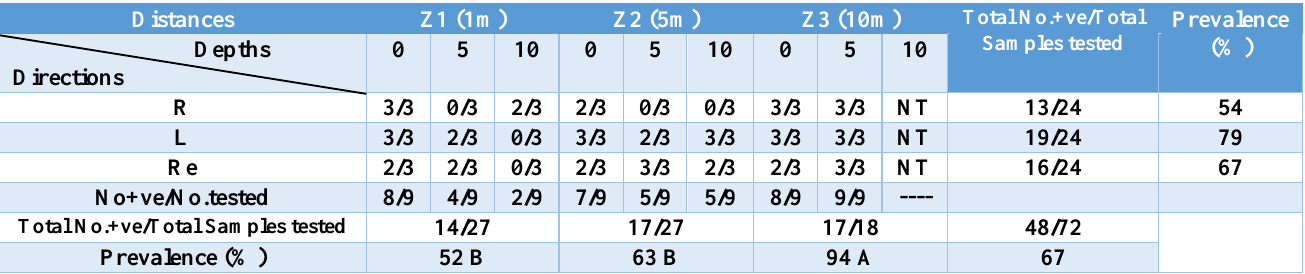
Z=Zone, O=Surface, NT=Not tested (tilled land), R=Right side, L=Left side, and Re=Rear side of the farm Different uppercase letters in the same row are significantly different (P<0.05)